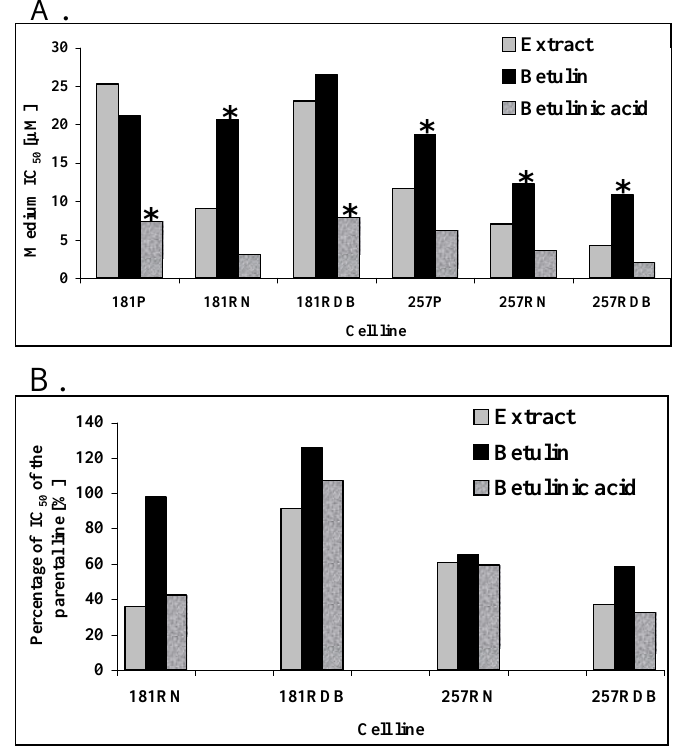
of the tested compounds. B: Relative IC Figure 3. A: IC 50 compounds for the drug resistant cell-lines compared to the parental lines (181RNOV and 181RDB compared to 181P, 257RNOV and 257RDB compared to